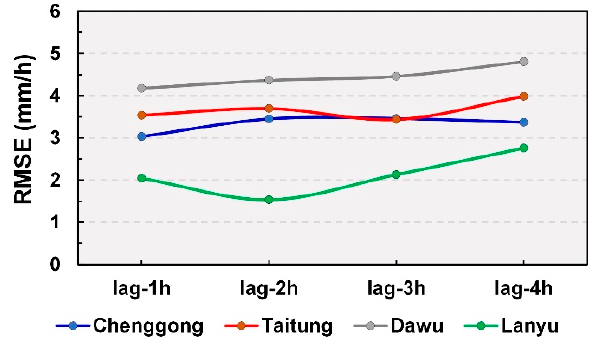
Figure 5. RMSE results at different lag times for each station.